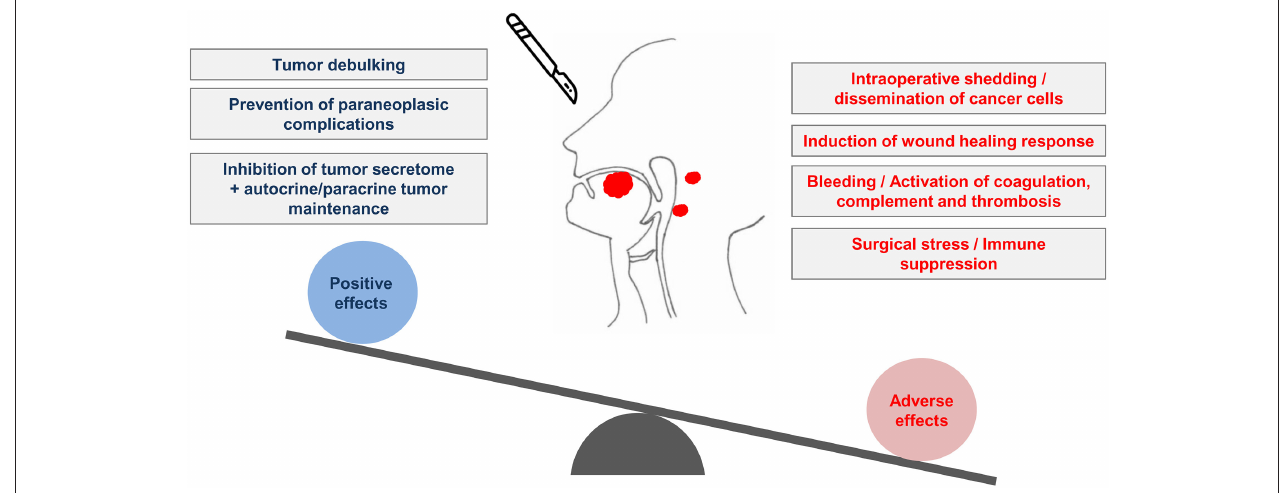
FIGURE 1 | The perioperative period and the conflicting biological influences of surgery on tumors of the oral cavity. Surgery of OSCC produces both positive and adverse effects. The removal of the tumor leads to the beneficial effects of debulking and inhibition of the tumor secretome. Conversely, OSCC surgery can lead to neoplastic cell dissemination. The concomitant surgical stress and the activation of coagulation as a consequence of bleeding may create biological conditions prone to post-surgical recurrence of